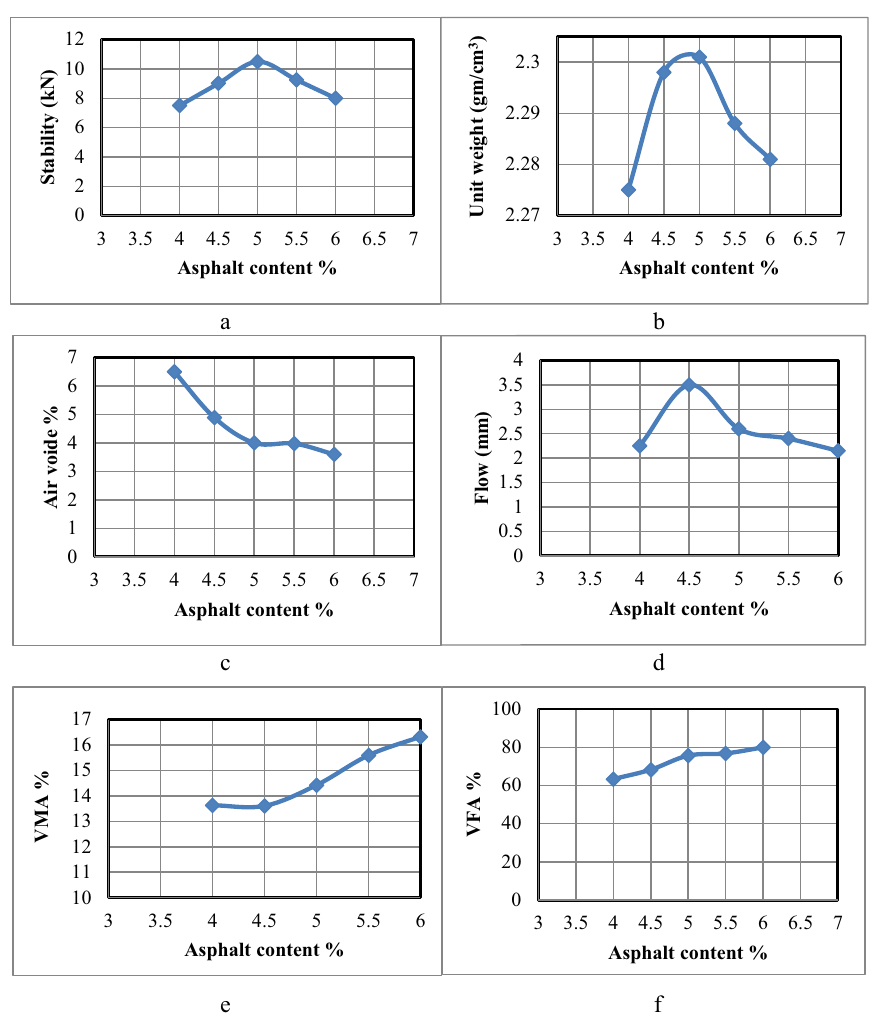
Figure 1: Results of Marshall test. ( a ) stability vs. asphalt content, ( b ) unit weight vs. asphalt content, ( c ) air voids vs. asphalt content, ( d ) fl ow vs. asphalt content, ( e ) VMA ( void mineral aggregate ) vs. asphalt content, ( f ) VFA ( void fi ller aggregate ) vs. asphalt content.